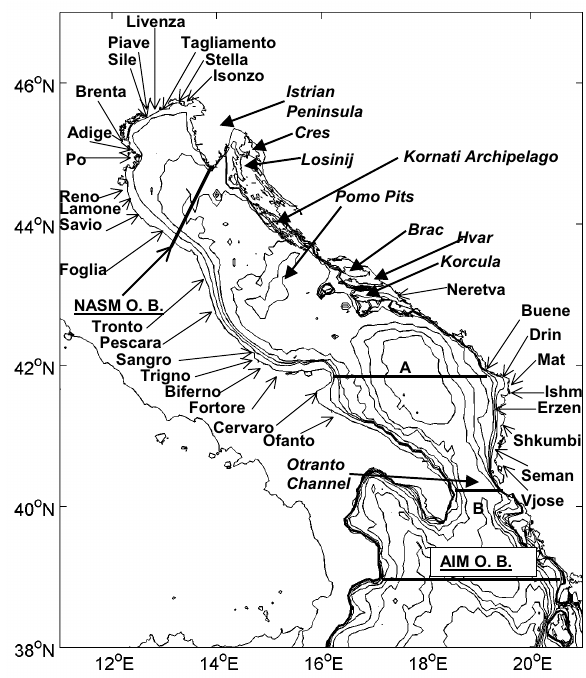
Fig. 1. The Adriatic Sea coastal and bottom morphology. The figure also shows the approximate location of the Adriatic Rivers’ mouth discharging into the basin, the location of the AIM and NASM open boundaries (AIM O.B. and NASM O.B., respectively), the location of the sections shown in Fig. 12 (A) and Fig. 13 (B) and the location of the islands retained by the AIM model geometry.